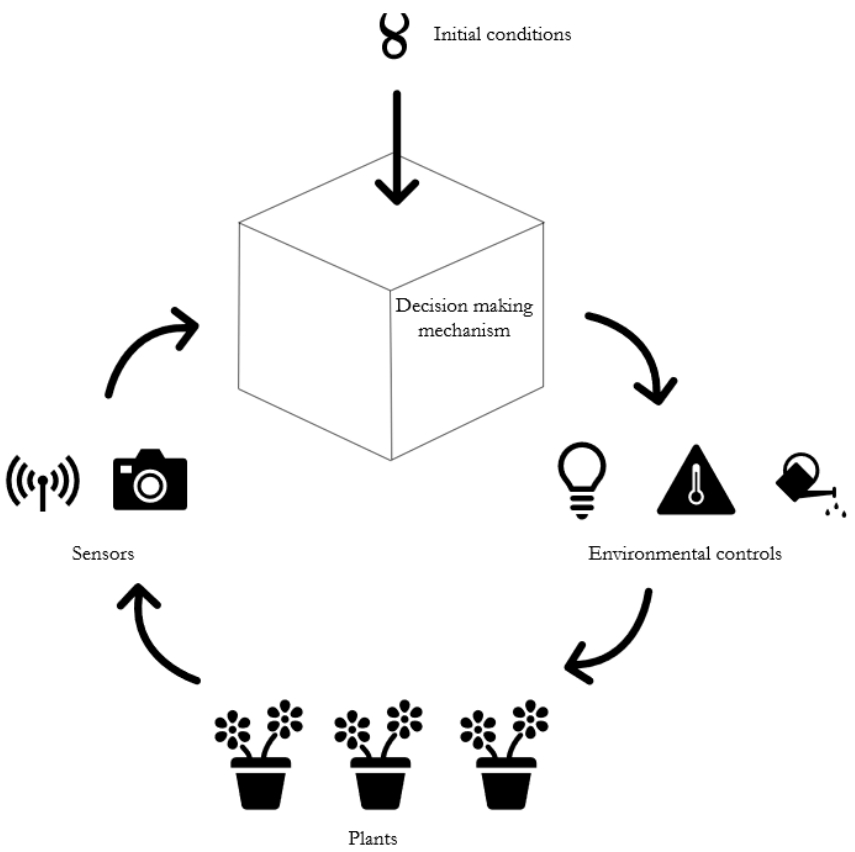
Figure 1. A real-time ambient intelligent horticultural system can ensure plant growth and development by controlling the environmental conditions, such as optical radiation, temperature, and moisture, without human intervention. Sensors can be used to identify the plant morphology, vital signs, and crop quality.